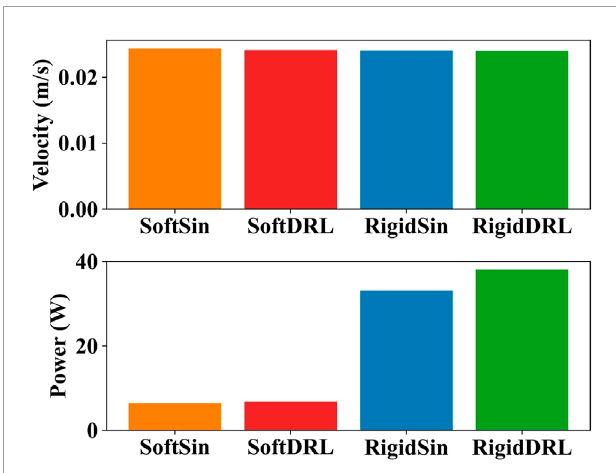
FIGURE 8 The test results for the four selected gaits, in order from left to right, are soft snake robot with gait equation controller, soft snake robot with DRL controller, rigid snake robot with gait equation controller and rigid snake robot with DRL controller.